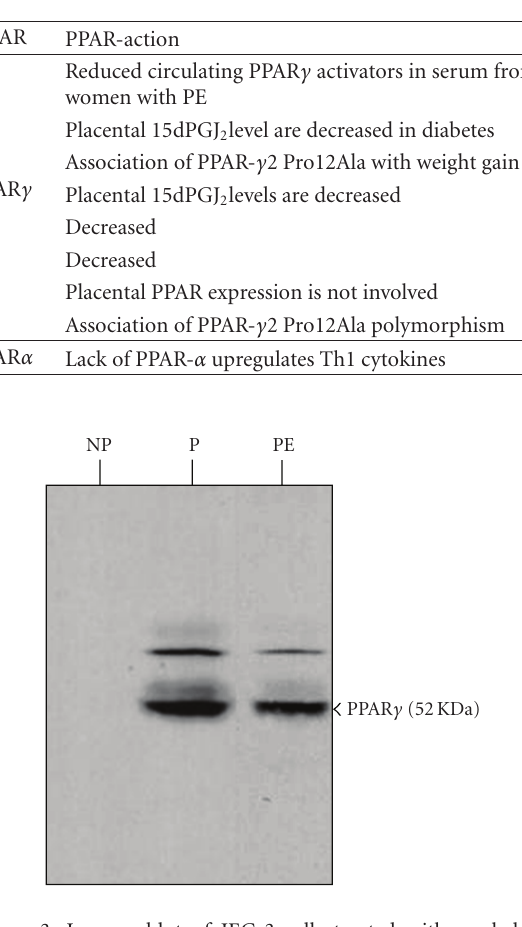
Figure 3: Immunoblot of JEG-3 cells treated with pooled sera (10%) from nonpregnant (NP), pregnant (P), and preeclamptic (PE) women. Cell lysates were analyzed using a specific mouse anti- human PPAR γ monoclonal antibody. Equal amounts of protein (50 μ g) were loaded into each lane. Factors in pregnant serum up- regulate JEG-3 PPAR γ expression. A decrease in PPAR γ protein was observed in cells exposed to PE sera (PE) compared to sera from normal pregnant women